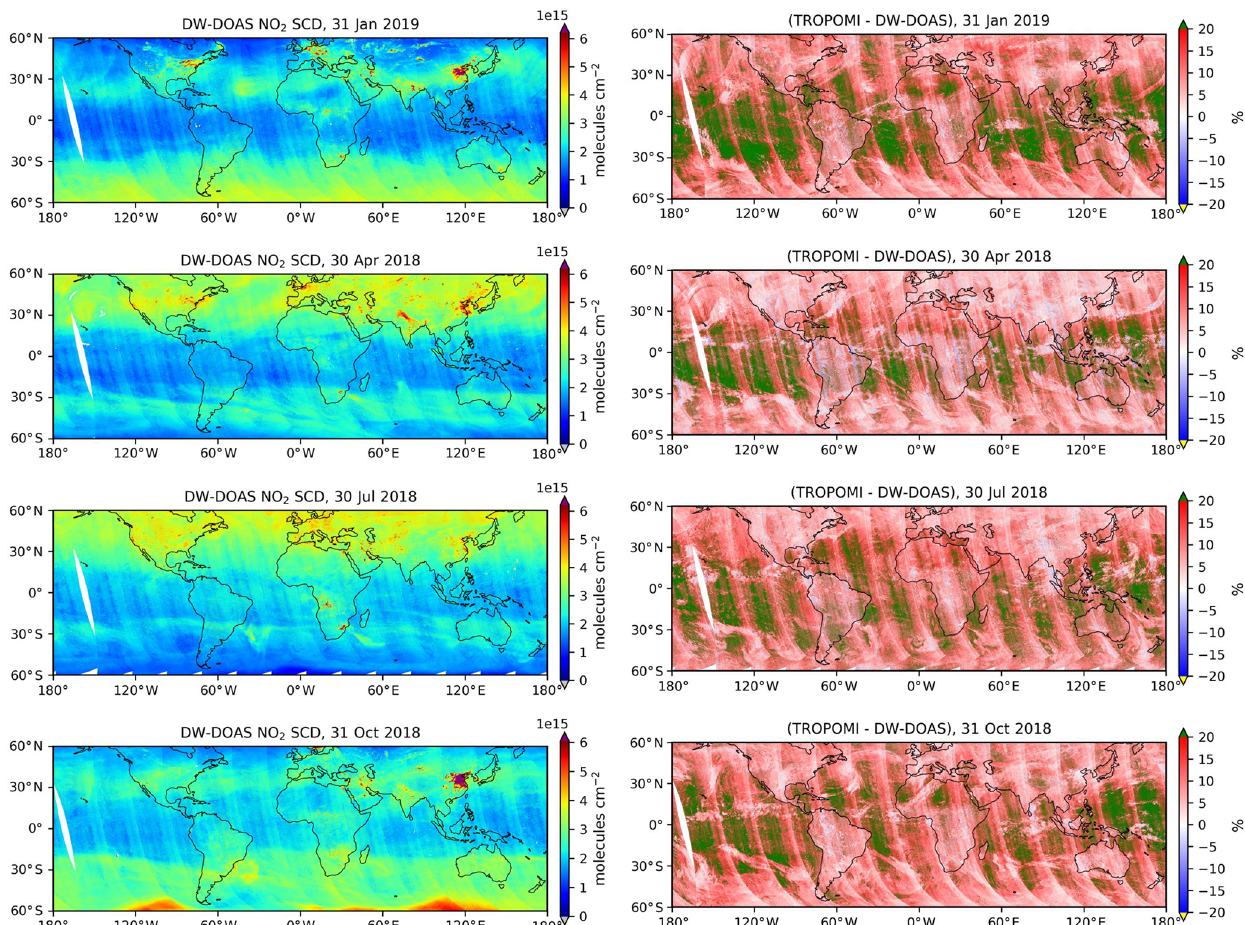
Figure 9. (left) Global DW-DOAS NO 2 SCDs scaled with geometric AMFs (for clearer data visualisation) for all single orbits of 1d in January of 2019, and April, July, and October of 2018, and (right) the relative differences with TROPOMI calculated as (TROPOMI – DW- DOAS)/TROPOMI and expressed in percentage. The latitudes are limited to [60 ◦ S, 80 ◦ N]. All the data are screened using the QA flag (QA > 0 . 5) from the TROPOMI NO 2 level 2 dataset, which includes all-sky